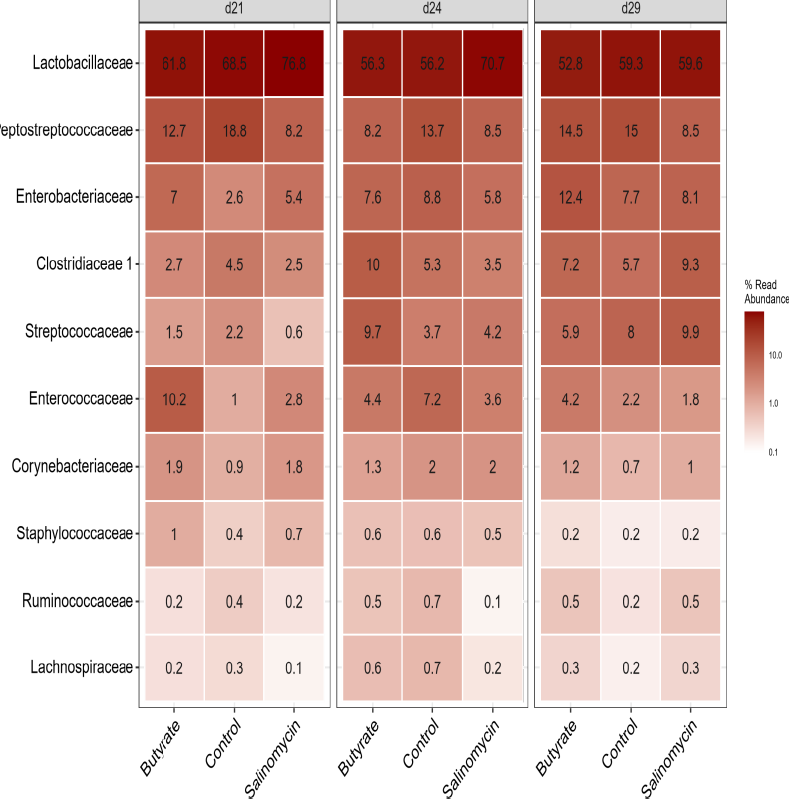
Figure 6. Heatmap showing the relative abundance of the top 10 most abundant microbiota at the family level across all ceca samples (irrespective of treatment or age) and visualized for each age